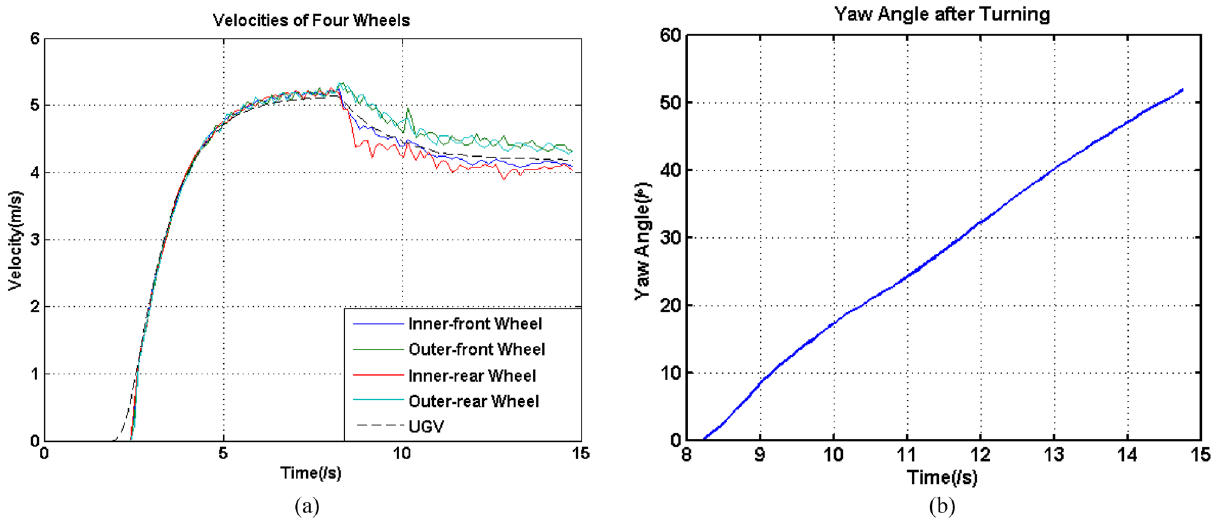
Figure 7. ( a ) Velocities of wheels and UGV, ( b ) yaw angle during the turning